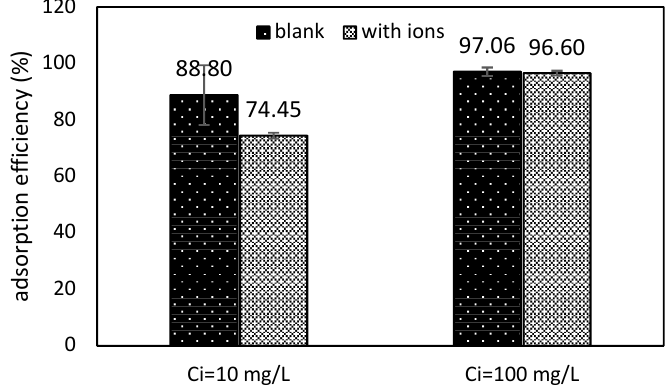
Figure 6. Ion competition (Sorbent dose: 1 g/L; contact time: 24 h; agitation rate: 150 rpm).